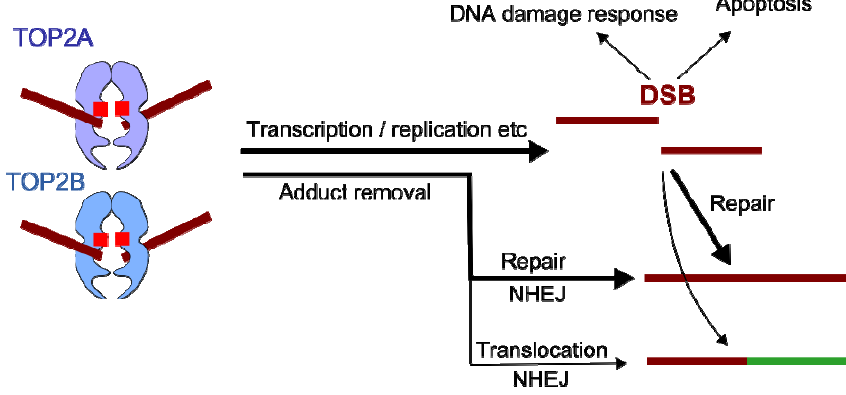
Figure 3. TOP2 Poisons, downstream events. TOP2 poisons inhibit the religation step of the TOP2 reaction cycle, leading to accumulation of covalent TOP2-DNA cleavage complexes. These lesions are cytotoxic and lead to activation of the DNA damage response and potentially apoptosis. Alternatively these lesions are repaired, largely through the non-homologous end-joining pathway. Translocations observed in